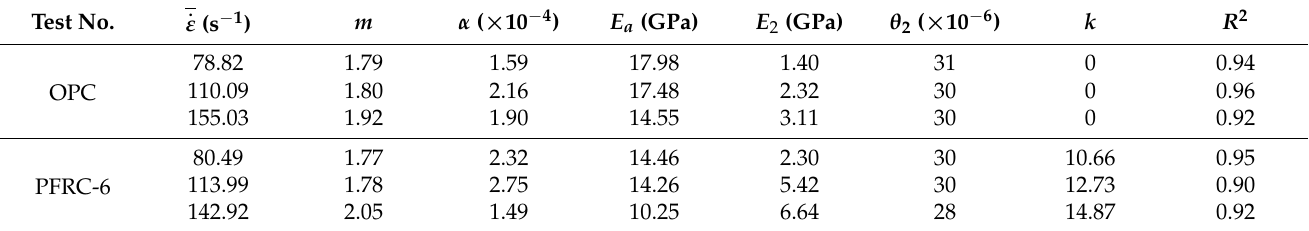
Table 9. Constitutive model fitting